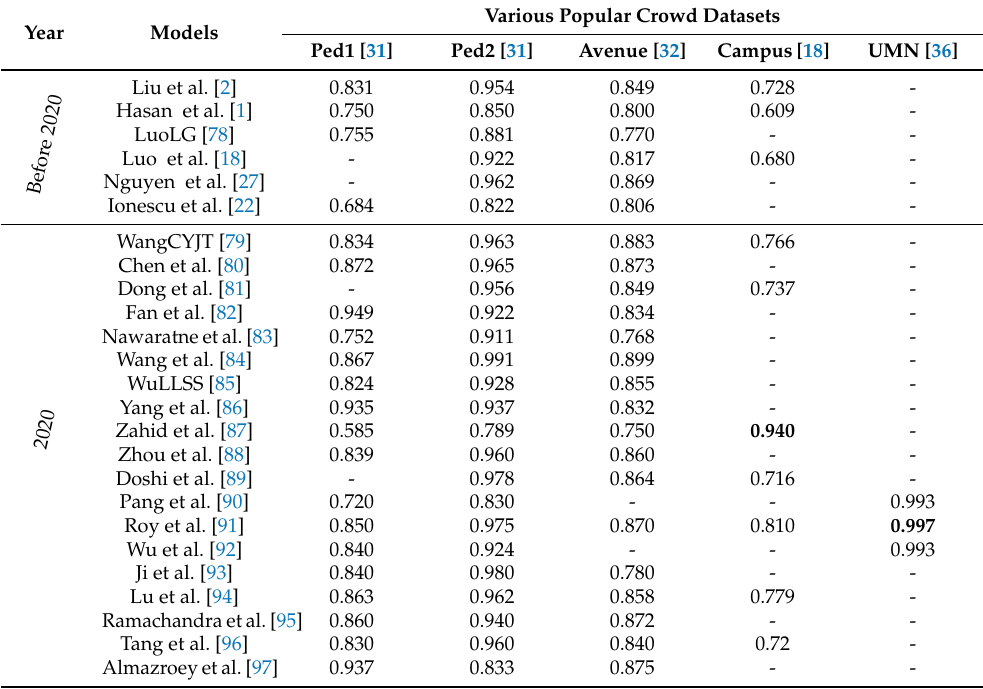
Table 5. Frame-level AUC score comparison of miscellaneous methods and datasets. Column-wise the best numerical result is shown in bold